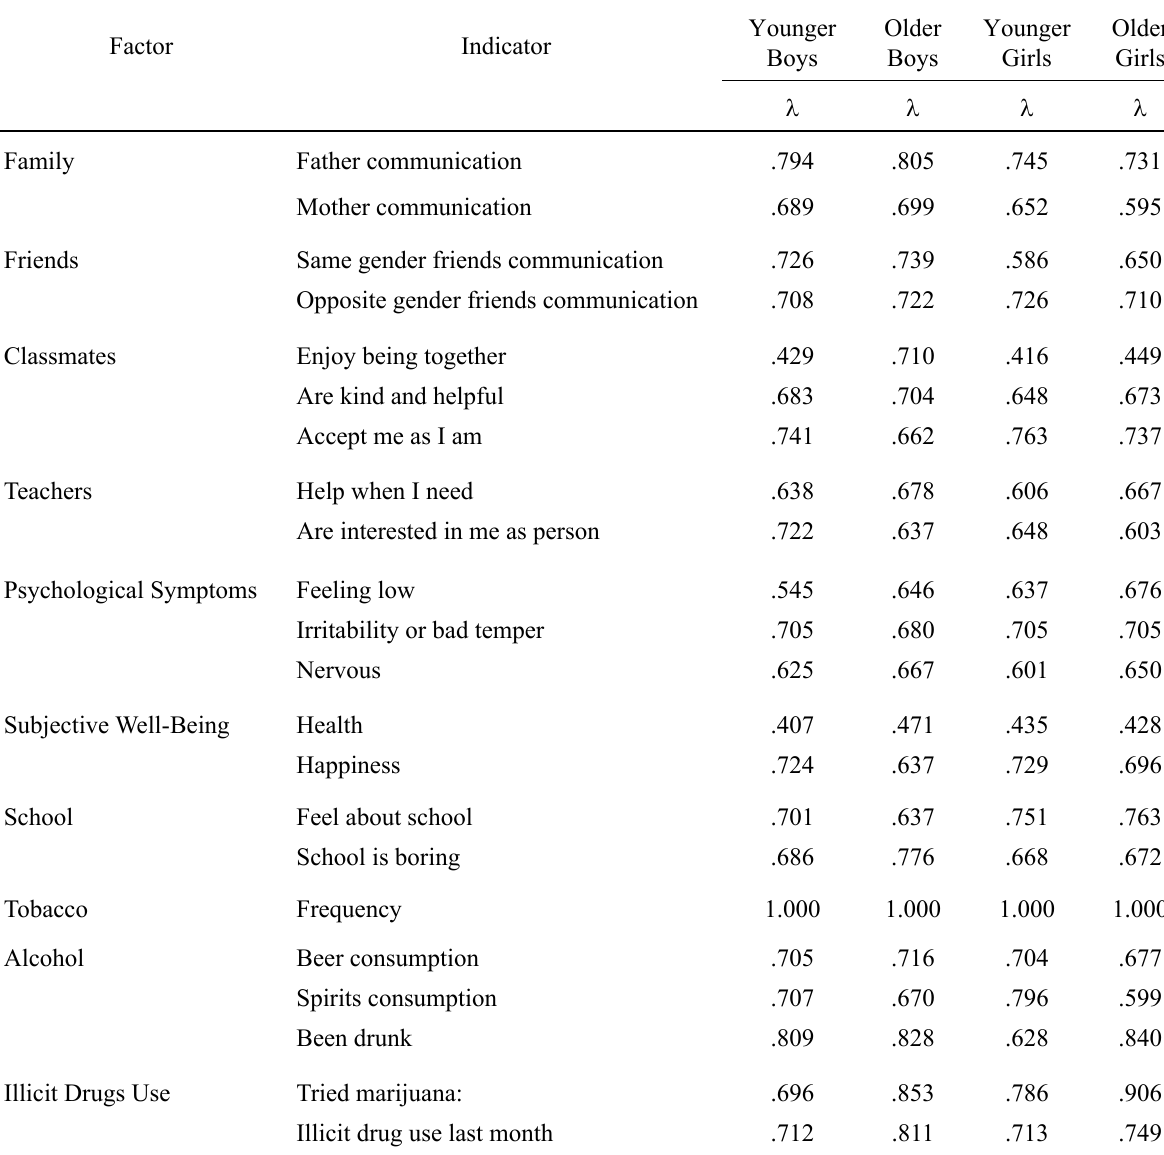
Factor Loadings (  ) of the Ten Factors Indicators in the Model for Each of the Four Groups